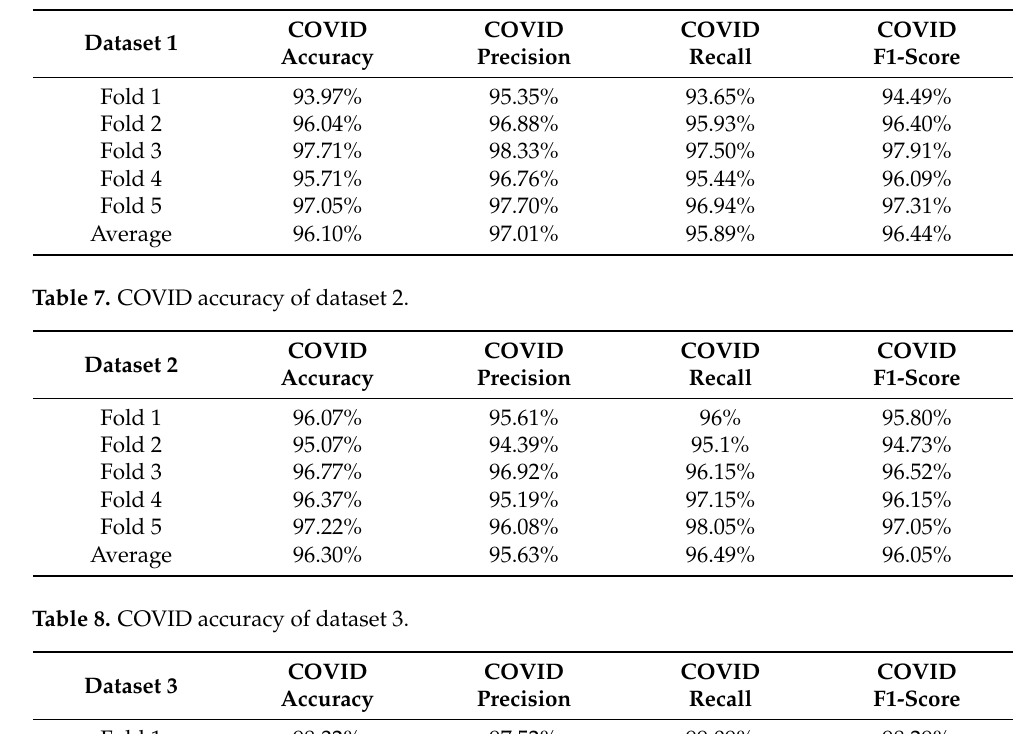
Table 6. COVID accuracy of dataset 1.